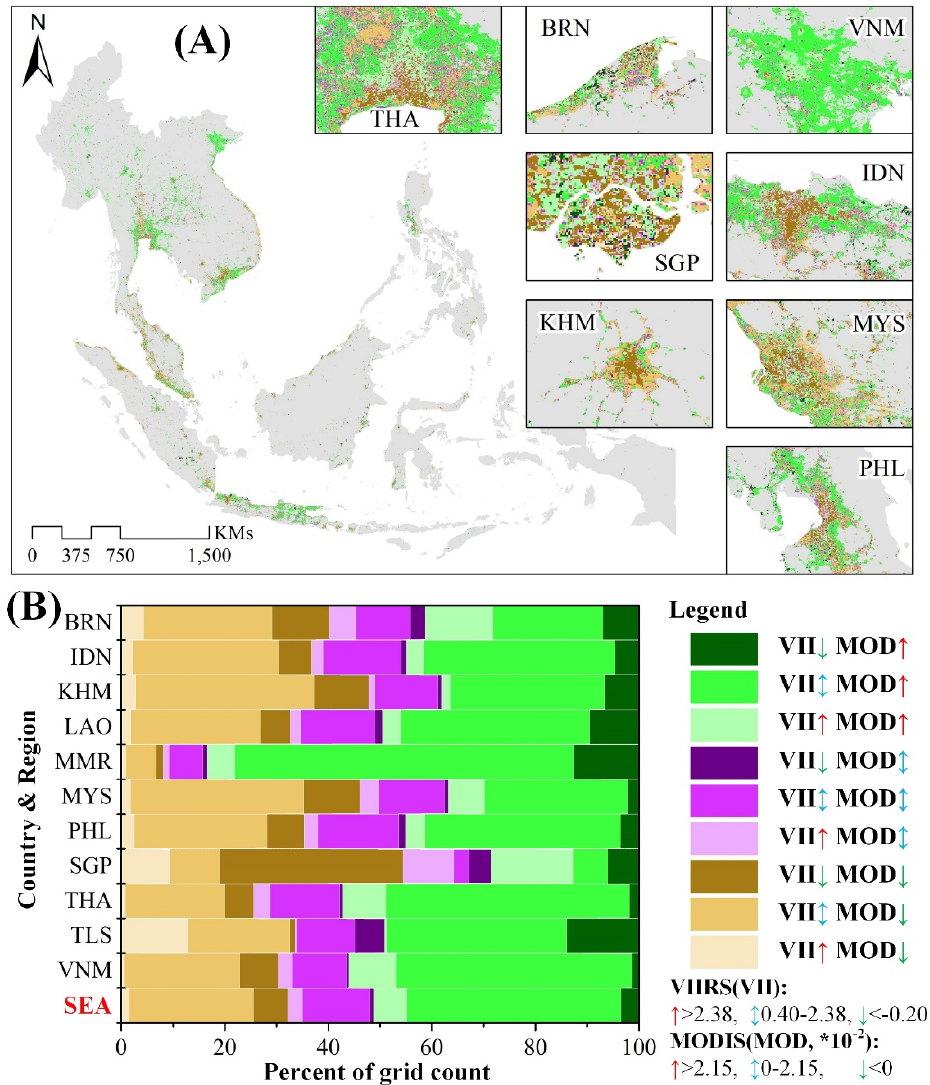
Figure 5. The spatial pattern (A) and statistics (B) between VIIRS/DNB overall trend and MODIS/NDVI overall trend for the whole Southeast Asia region (SEA, grids count: ≈ 1.85×10 6 ) and 11 countries. The color bar (B) shows the different proportion of grid density under different combinations of VIIRS/DNB and MODIS/NDVI change level.